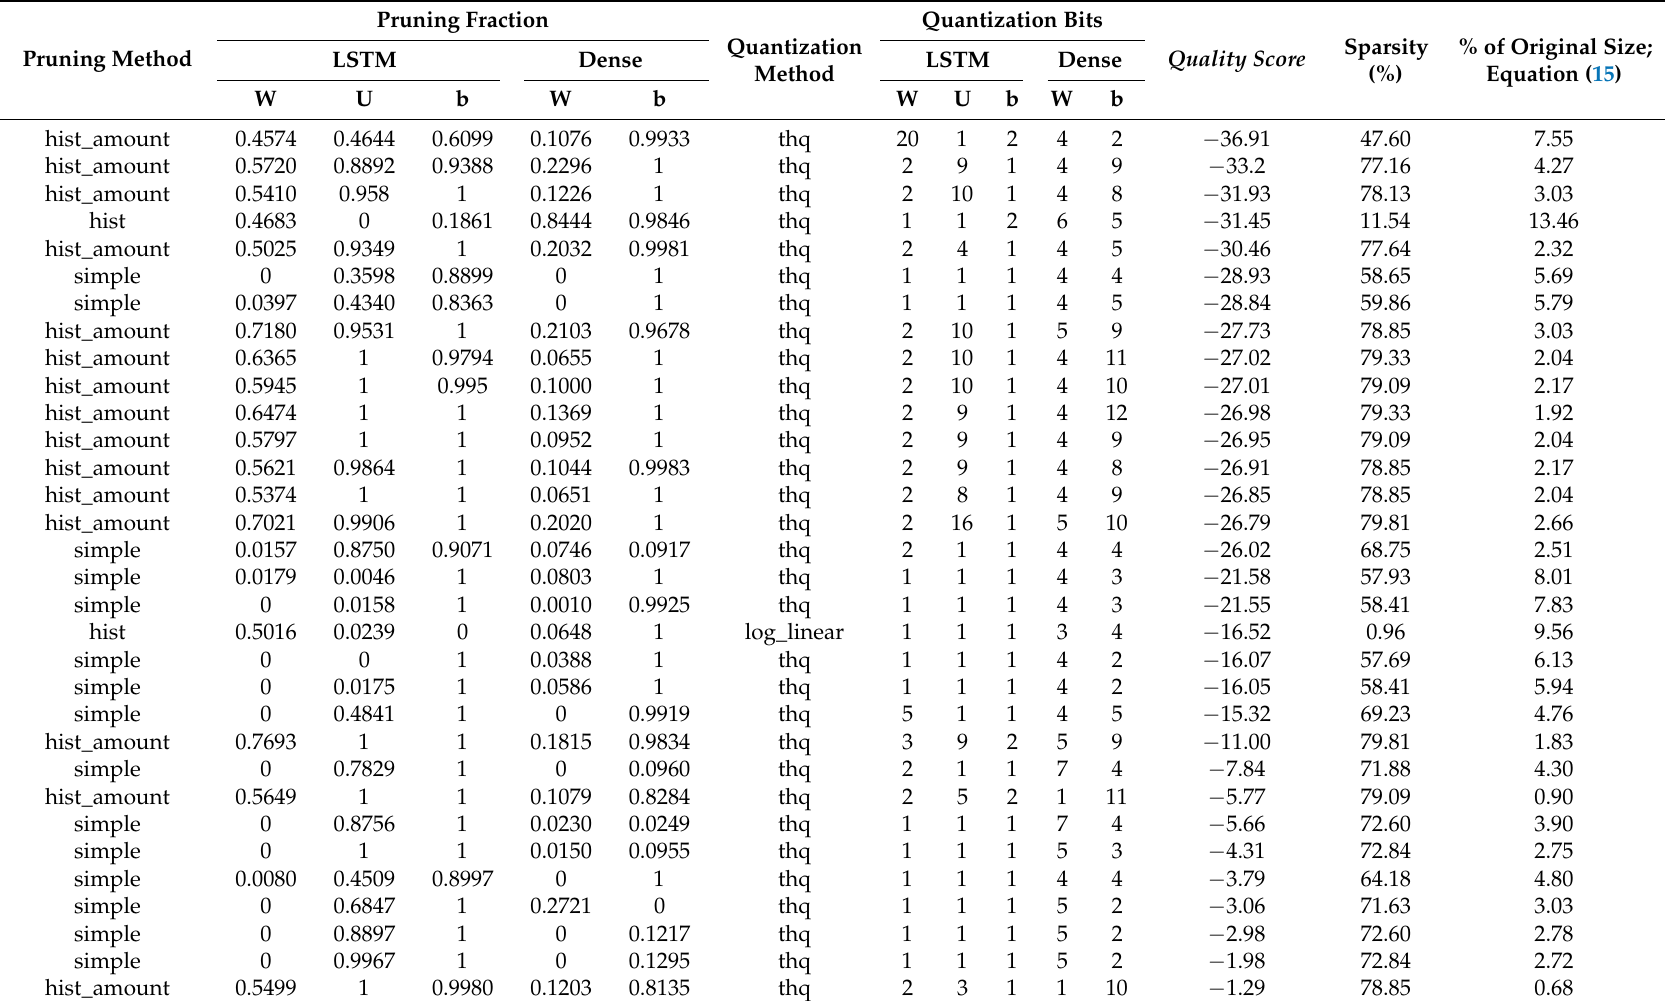
Table A2. [IAP] Results for individualized pruning and